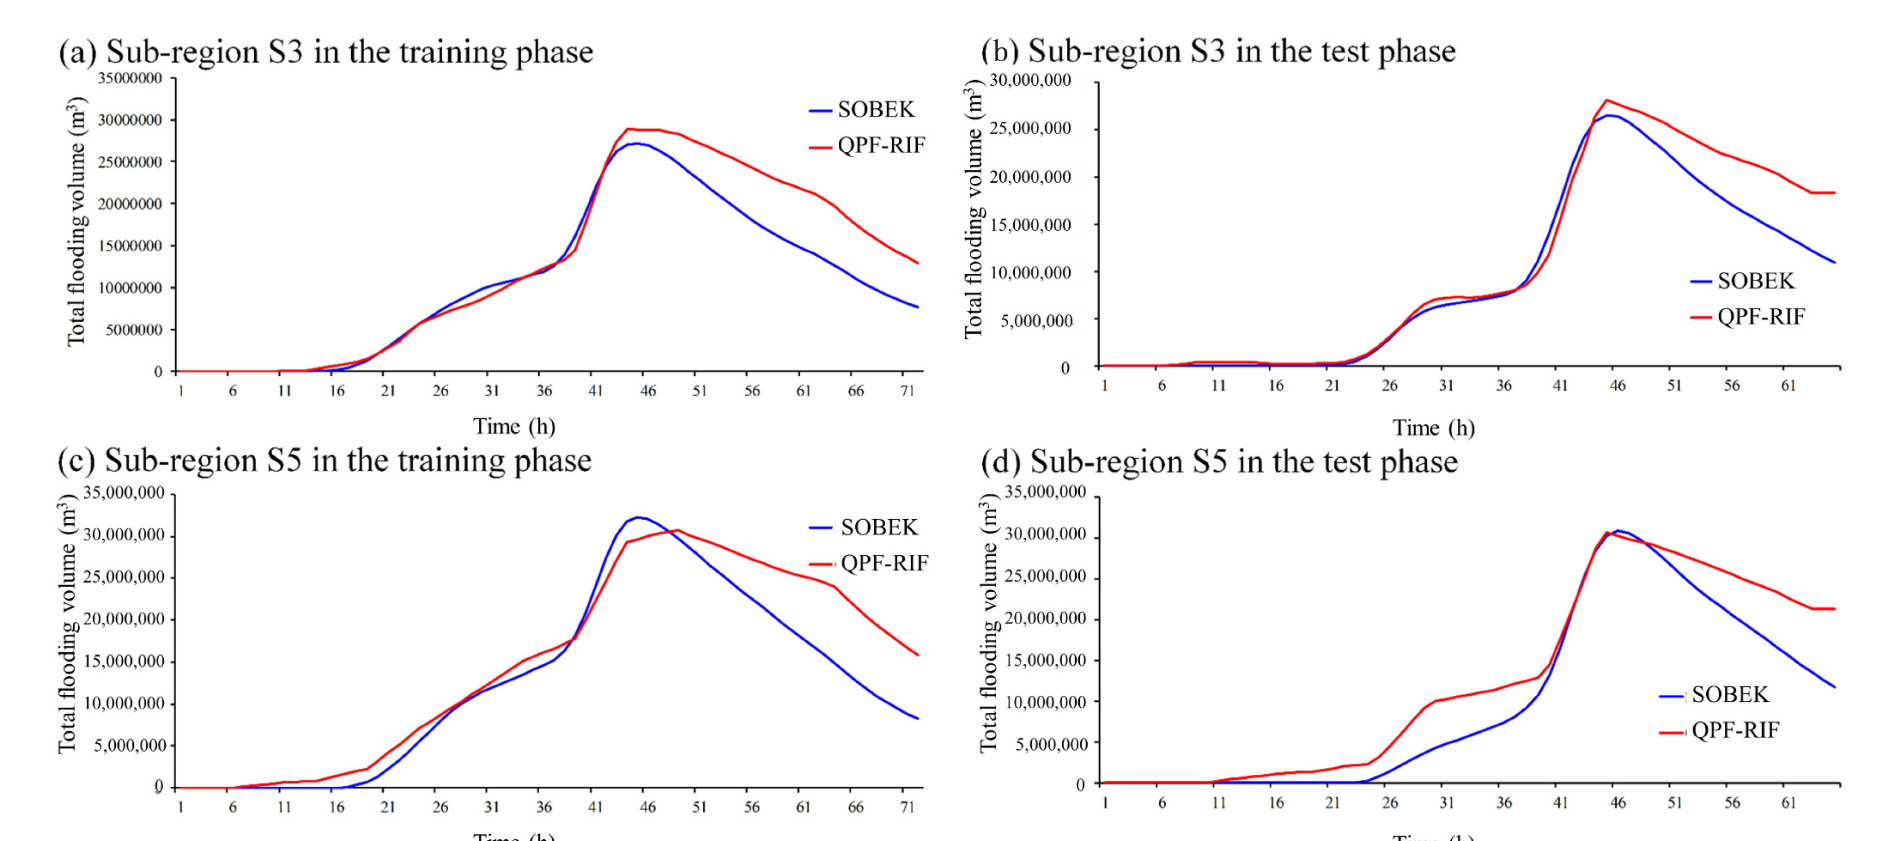
Figure 8. Comparison of the total flooding volume from 1 to 72 h lead-time forecasts of the SOBEK and SVM-MSF for S3 and S5 in the training and testing